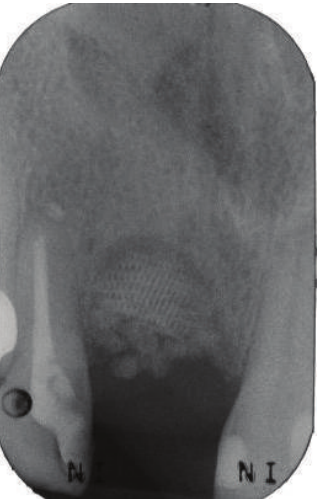
Figure 10: After 6 months of uneventful healing, a periapical radiograph showed good integration of the material used for regeneration.